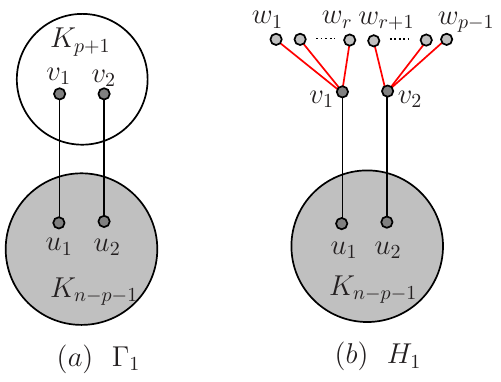
Figure 1. Graphs Γ 1 and H 1